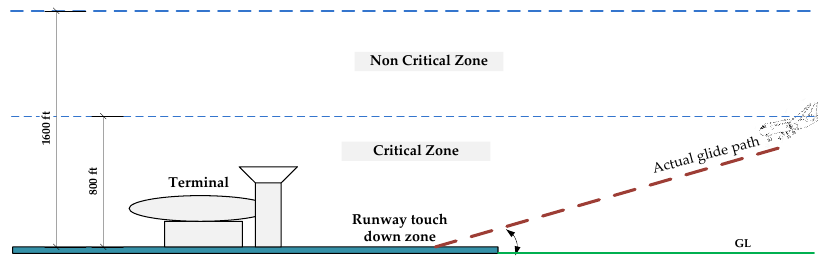
Figure 1. Occurrence location of LLWS events in the vicinity of an airport runway.